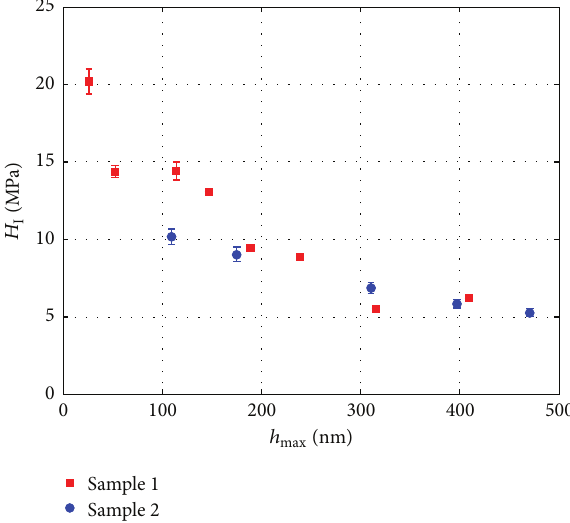
Figure 24: Indentation hardness of PDMS from two different samples obtained by a Berkovich tip with the same loading and unloading times of 40 s and a holding time of 3s (each point represents ten indentations)